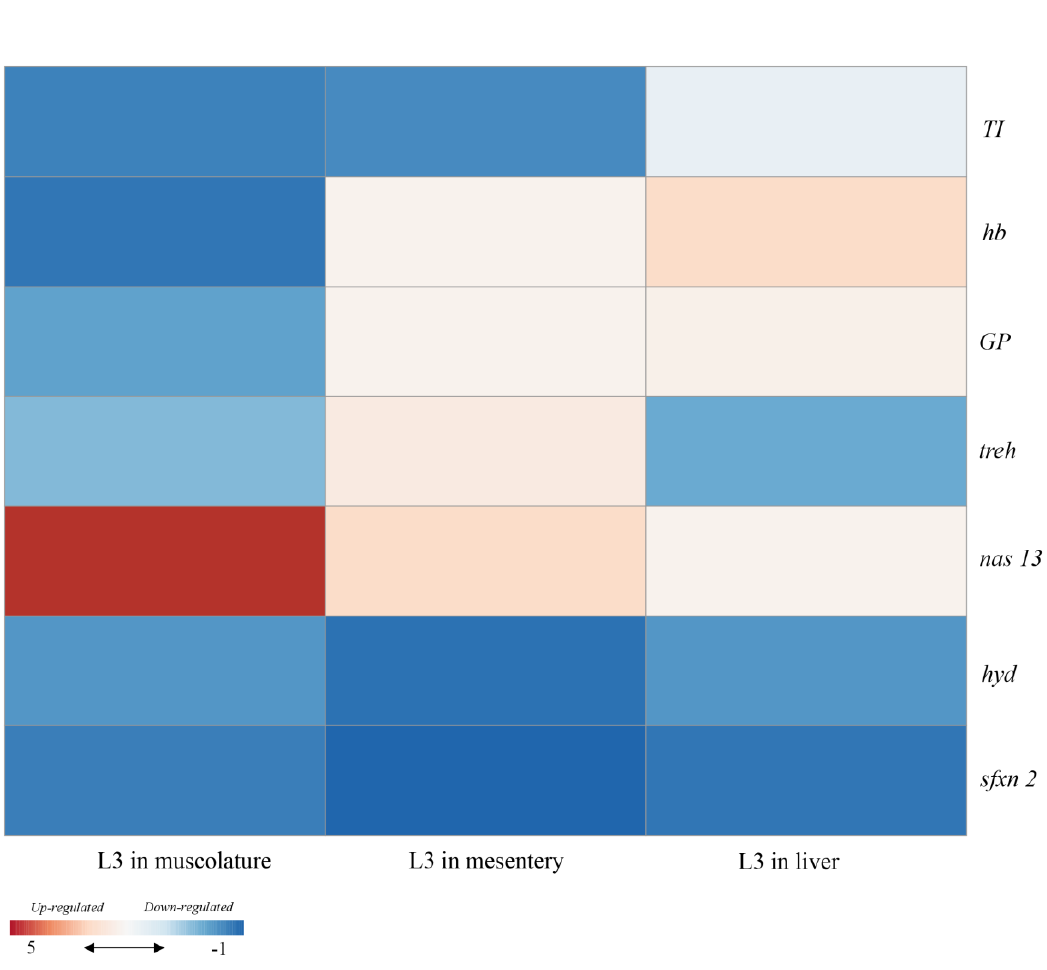
Figure 2. Heat map presenting the changes in the gene expression of Anisakis simplex (s.s.) larvae collected from different fish tissues. Gene expression was first calculated relative to the geometric mean of gpd and then was standardized following a standard score normalization against the corresponding control (larvae recovered in the internal lumen of the stomach) samples. Shades of red and blue, respectively, indicate the highest and lowest expression levels, as specified in the scale bar at the bottom of the figure. This heatmap was produced with the ClustVis web tool [83].